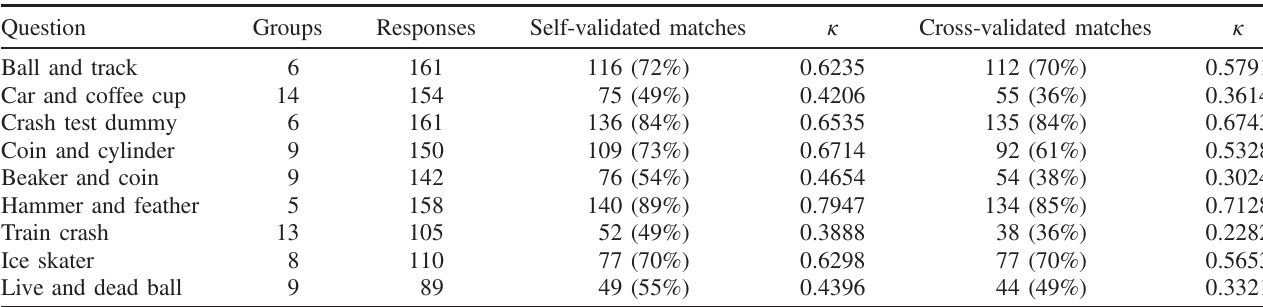
TABLE II. Self-validation and cross-validation success rates for the 9 questions